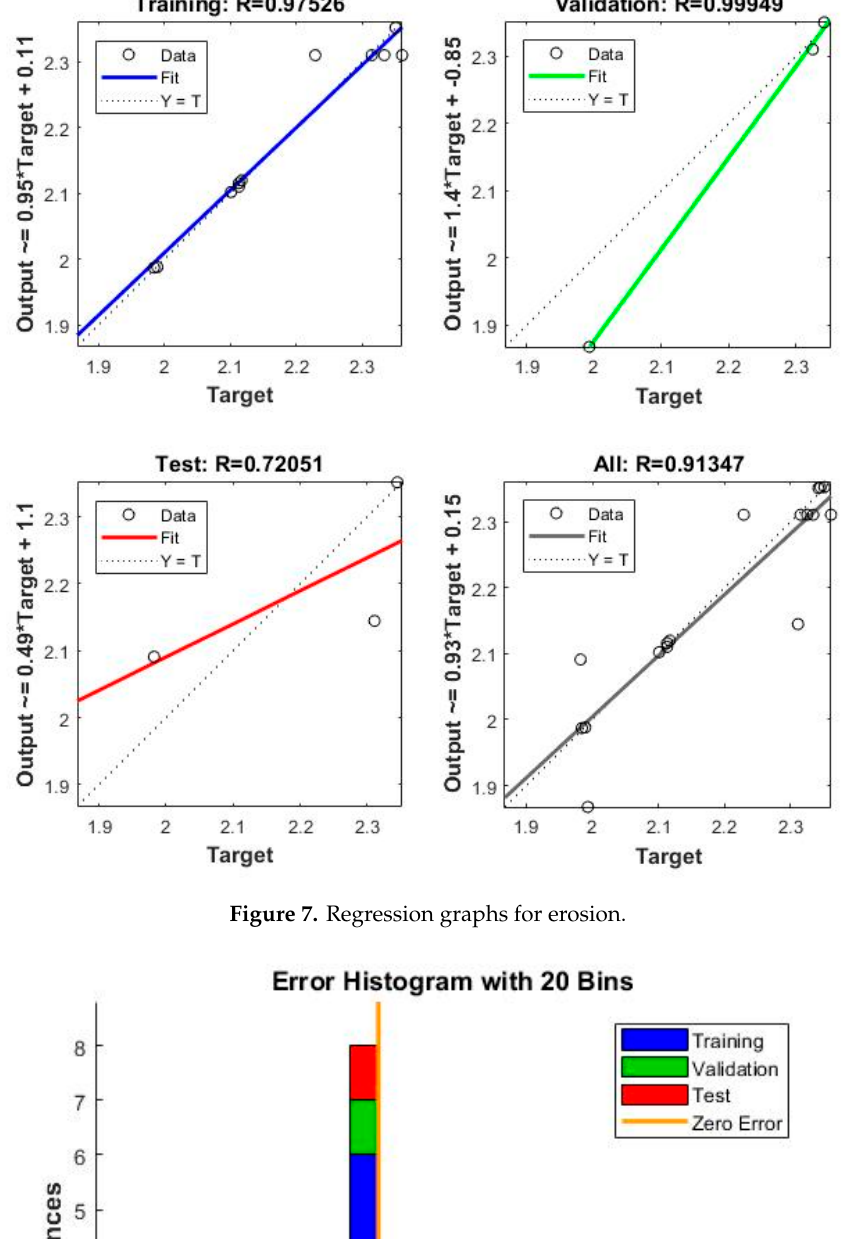
Materials 2020 , 13 , x FOR PEER REVIEW Figure 7. Regression graphs for erosion. Figure 7. Regression graphs for erosion. Table 4. Mean squared error and R values from model.